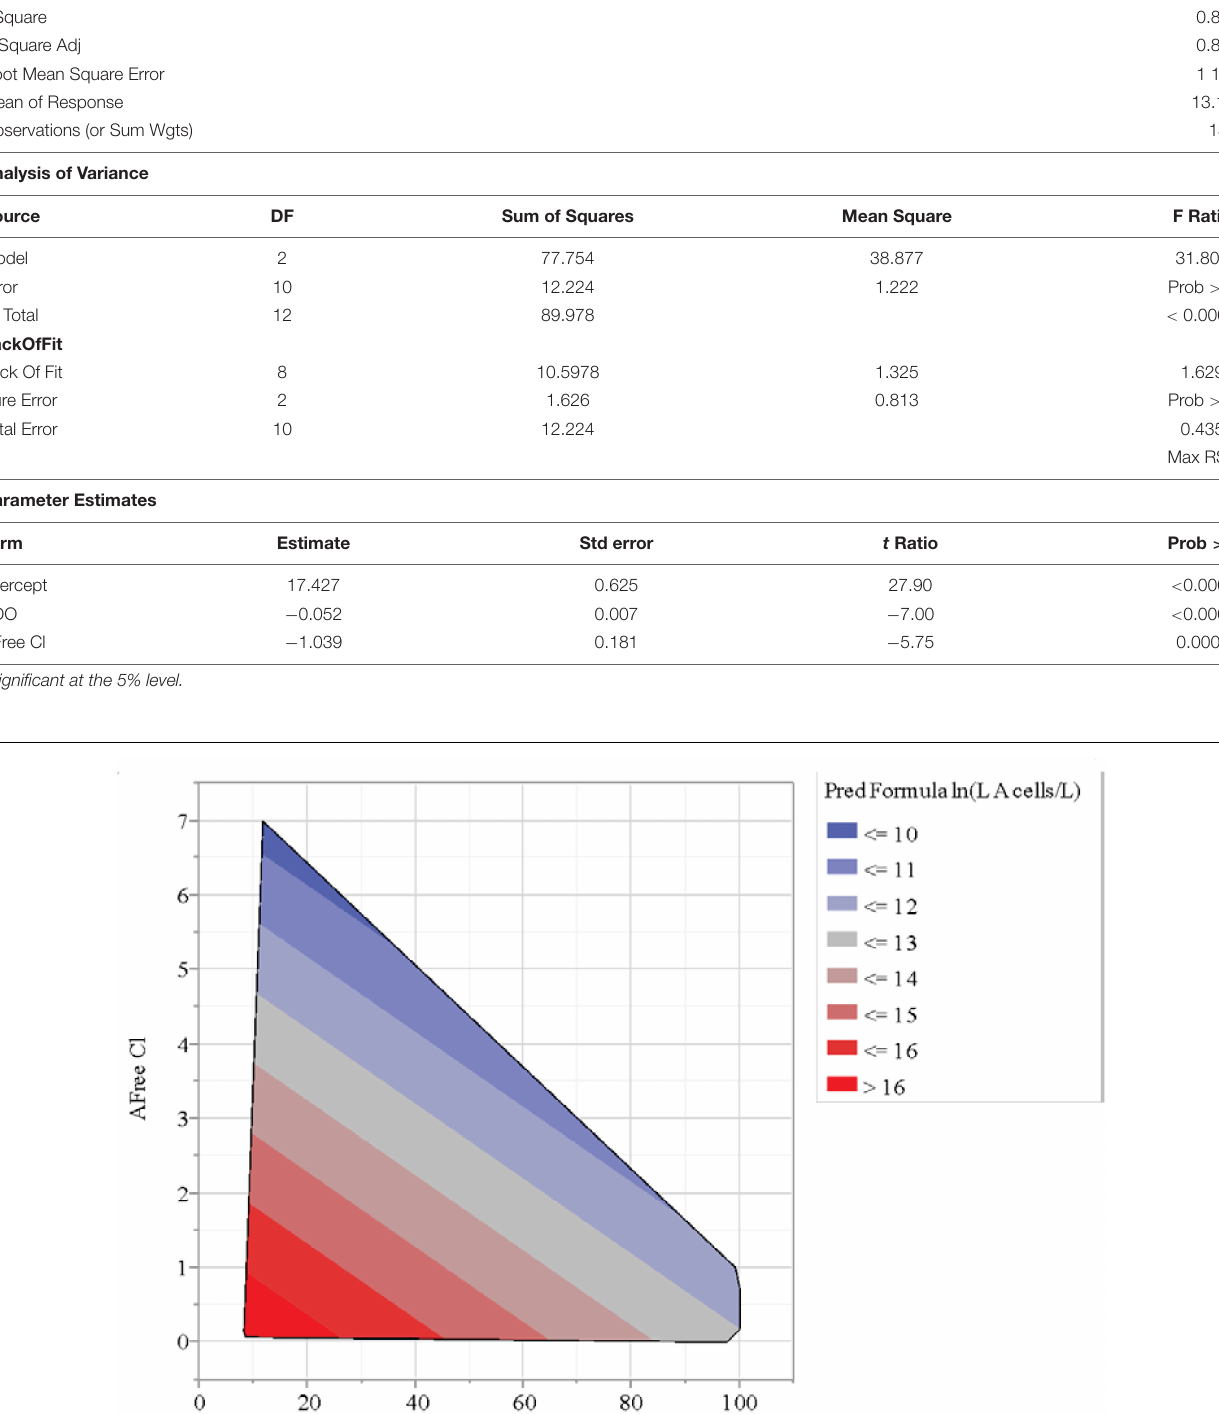
TABLE 2 | Analysis of variance for Cooling Tower 785-2A dissolved oxygen (DO) and free chlorine (Free Cl) relative to Legionella pneumophila concentrations. Summary of Fit